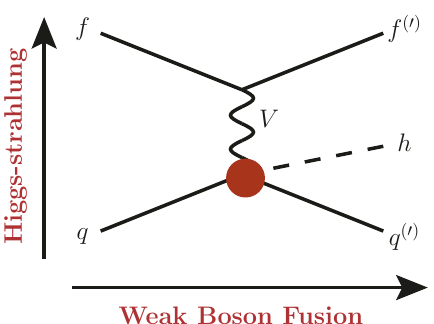
Figure 1 . Figure shows the crossing symmetry that exists between the Higgs-strahlung and VBF Higgs production processes. The amplitudes for the two processes are the same up to an exchange of the Mandelstam variables, s ↔ t . As a result the same four directions in SMEFT space control VBF Higgs production at high t and Higgs-strahlung at high s . The figure has been produced with the help of the JaxoDraw package